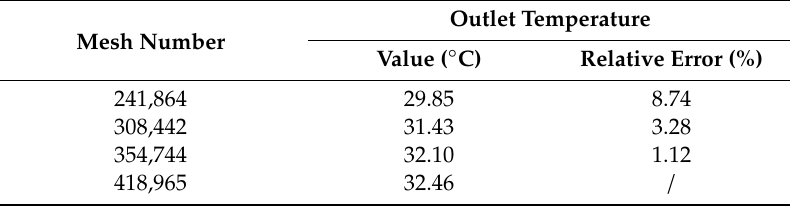
Table 1. Grid independence calculation for the spiral cooling